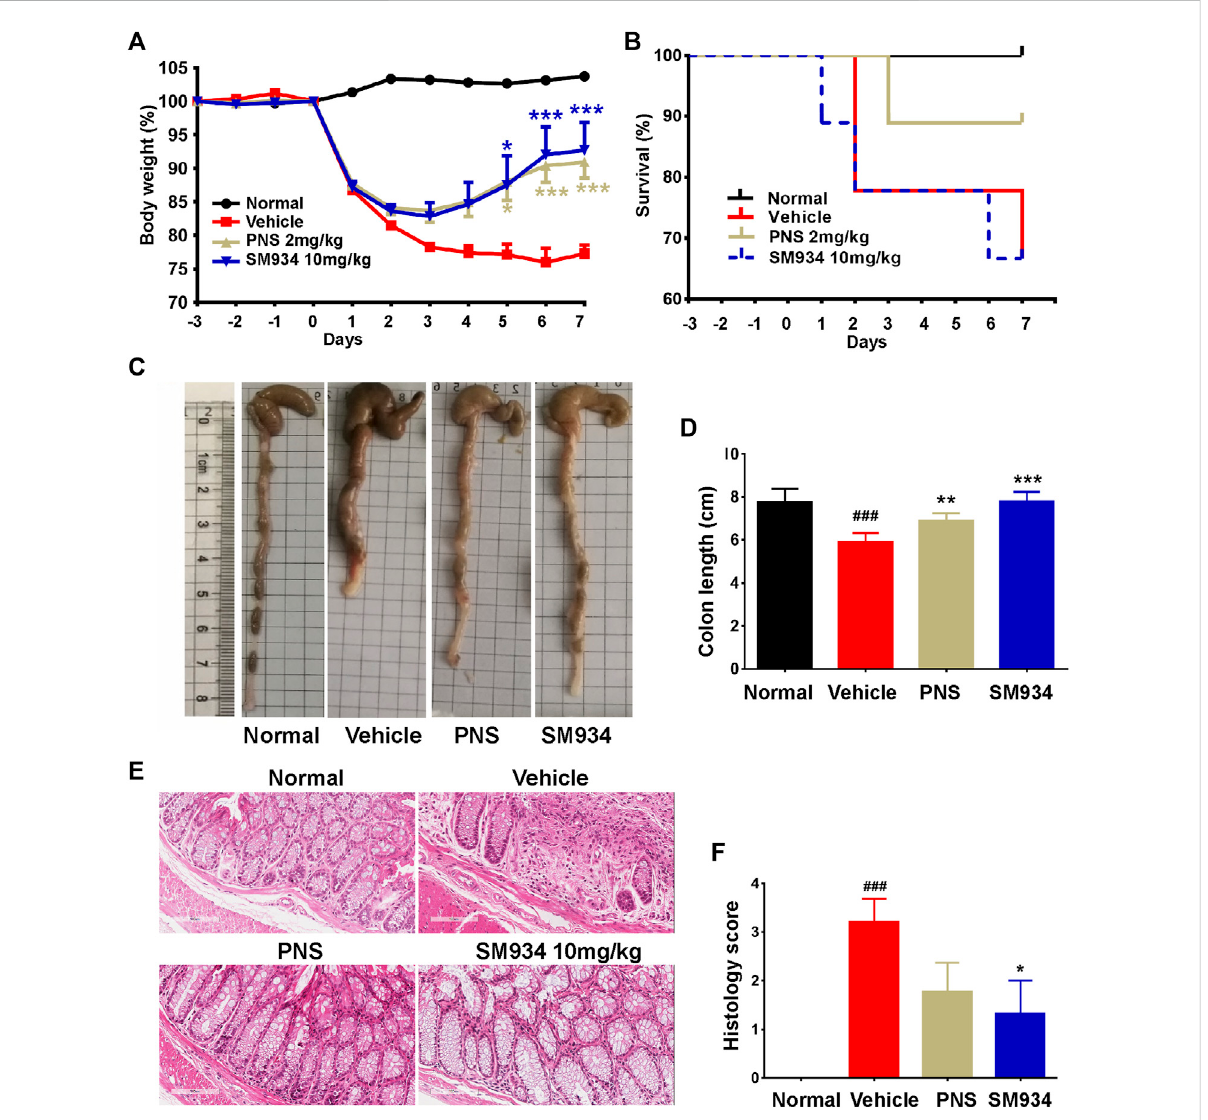
FIGURE 1 Effects of SM934 on TNBS-induced colitis in mice. (A) Body weight was monitored daily. (B) Survival curve. (C) Representative image of colons. (D) Averagecolonlengthofallgroups. (E) RepresentativeimagesofH&E-stainedcolonsectionsinmice(scalebars,400 µm). (F) Histologicalscoreof miceineachgroup.Dataarepresentedasmeans±SEM(n=9mice/group). ### p < 0.001vs . normalgroup;* p < 0.05,** p < 0.01,and*** p < 0.001vs . vehicle